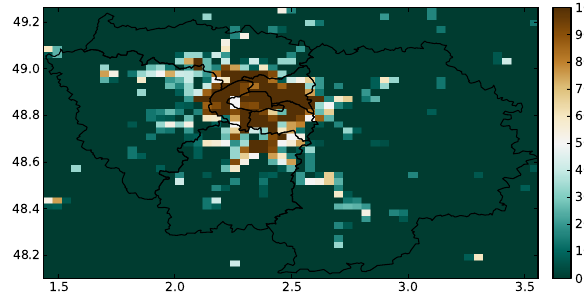
Figure 7. Spatial distribution of the “urban” land use derived from the GLC2000 database, given in percent of coverage for the cell of the used grid. The coordinates indicate longitude (east) and latitude (north). The black lines indicate the French administrative counties